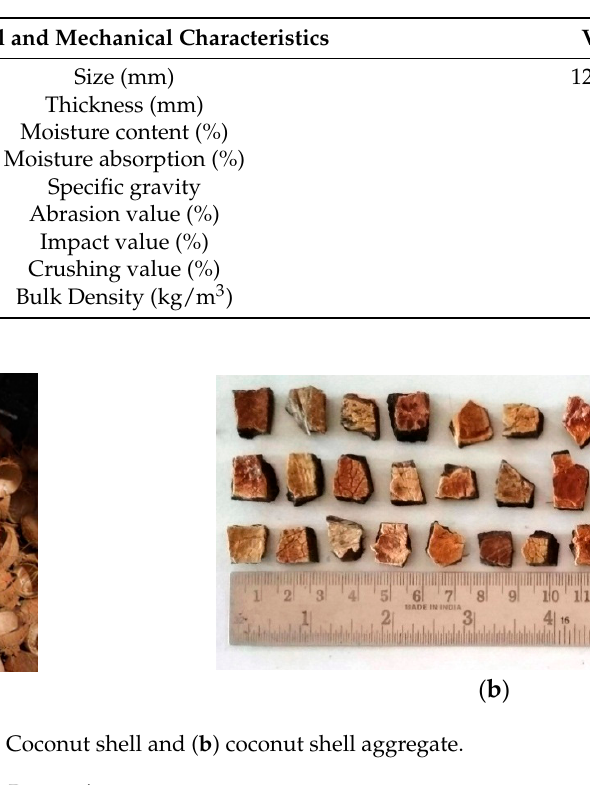
Table 1. The properties of the coconut shell aggregate.